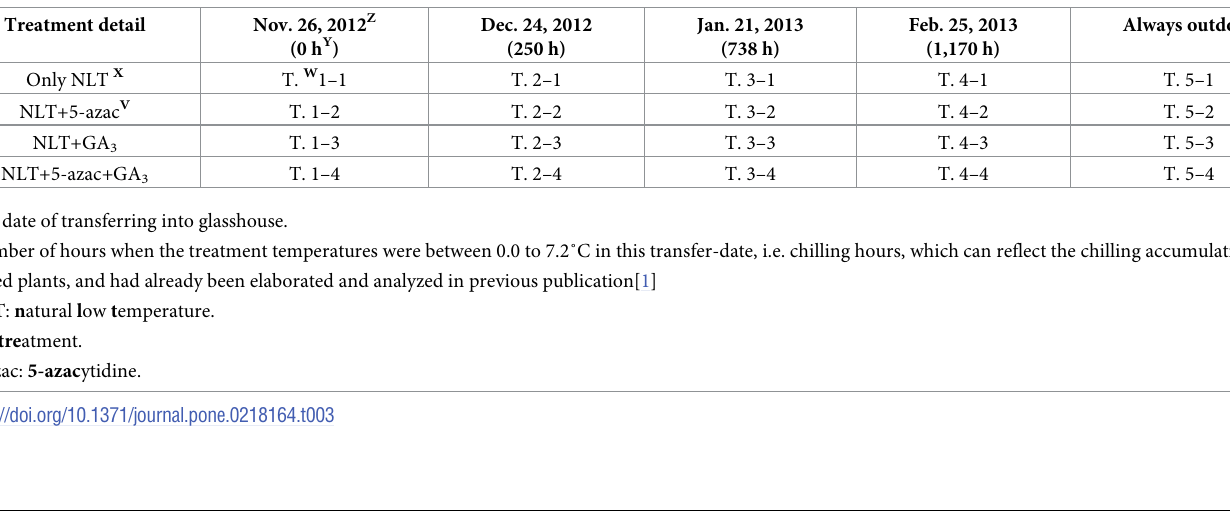
cultivars (unpublished data). Thus, in this study, ‘Hang Baishao’ was selected as a material for investigating the forcing culture of peony south of the Yangtze River. Outdoor potted crowns of ‘Hang Baishao’ were transferred from nursery into a glasshouse (15–25˚C, natural light levels and normal watering) at 9:00 a.m. on four transfer dates at an interval of four or five weeks from November 26, 2012 to February 25, 2013 (Table 3). Sub- groups of the potted crowns for each transfer date were assigned as follows: in the second sub- group (T. � -2 in Table 3), the dormant buds on crowns were painted by a brush pen immersed in 5-azacytidine solution (SIGMA, USA; 40 mg/L; NLT+5-azac in Table 3); in the third sub- group (T. � -3), the potted crowns were irrigated with gibberellin A3 (GA ) (SIGMA, USA; 300 3 mg/L, 150 mL per pot; NLT+GA in Table 3); and in the fourth subgroup (T. � -4), buds were 3 painted with 5-azacytidine, and crowns were irrigated by GA simultaneously (NLT+5-azac 3 +GA in Table 3). These three treatments were performed three times in November of 2012 3 before the first transfer date (seven pots per replicate and three replicates per treatment). Experiment Ⅱ : Artificial low temperature and humic acid. The potted crowns were treated in refrigerated storage (0–4˚C, cleaned and sterilized, without light and water) at 9:00 a.m. on Nov. 29, 2013, then transferred into a glasshouse on six transfer dates with one-week intervals (Table 4, chilling treatment for one to five weeks in refrigerated storage). The plants of “T. 6- � ” in Table 4, which received no artificial chilling, were directly transferred into a greenhouse on Nov. 29. The potted crowns were irrigated with humic acid (HA) (Ziming Organic Agricultural Chemistry, China) at concentrations of 0, 300, 600 and 900 mg/L (250 mL/pot) twice a week until flowering in glasshouse (Table 4, three replicates and three pots per replicate).